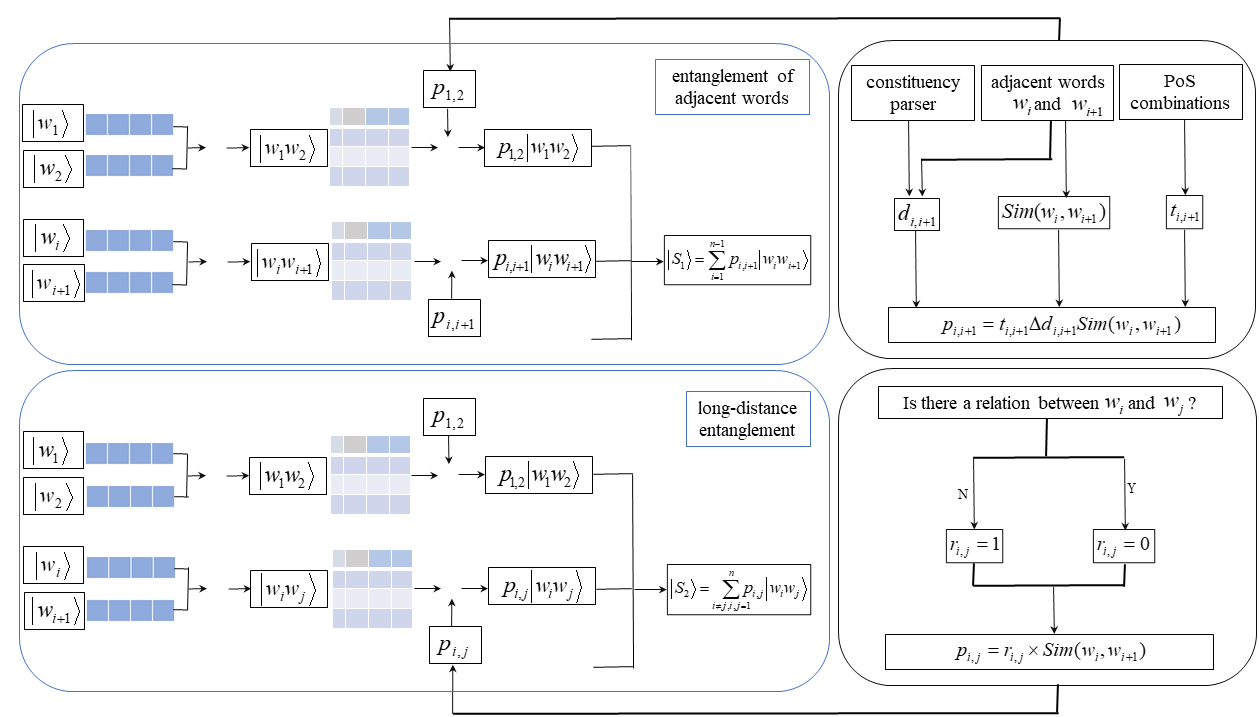
Figure 2. Flowchart of the quantum language-inspired tree structural text representation